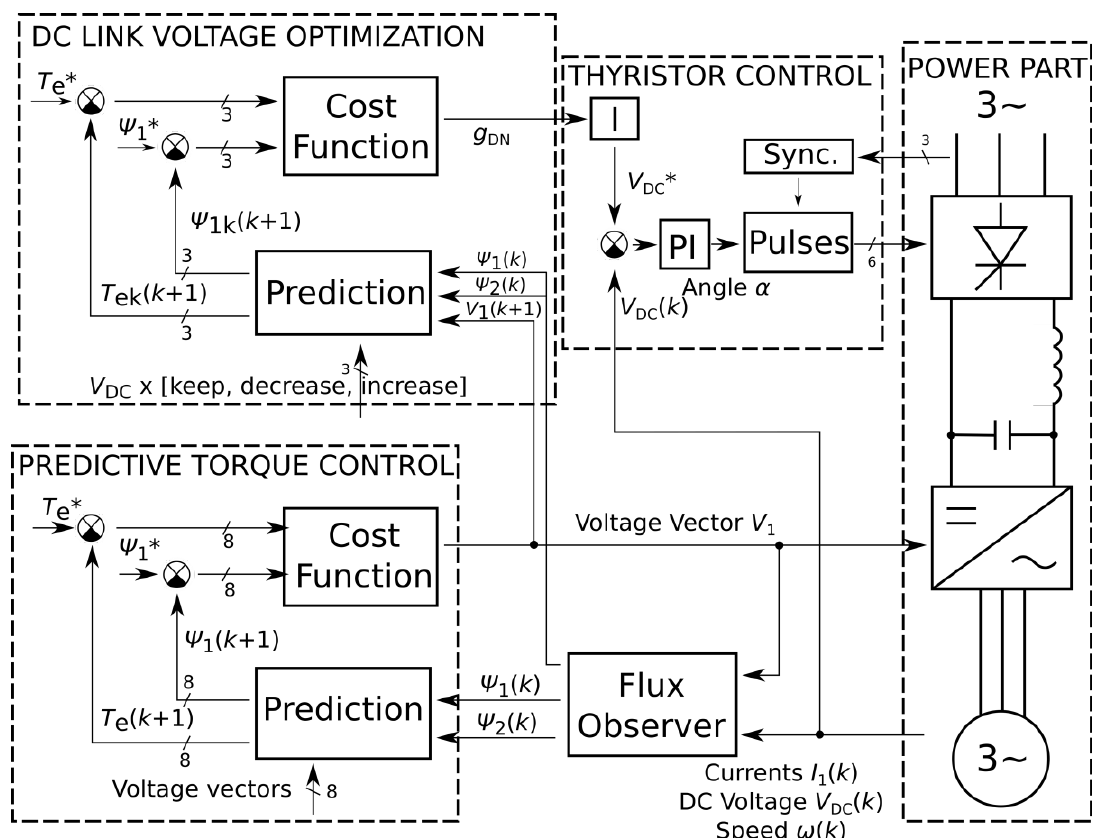
Figure 2. Predictive torque control (PTC) with adjustable DC-link voltage operation scheme. Electronics 2020 , 9 , x FOR PEER REVIEW